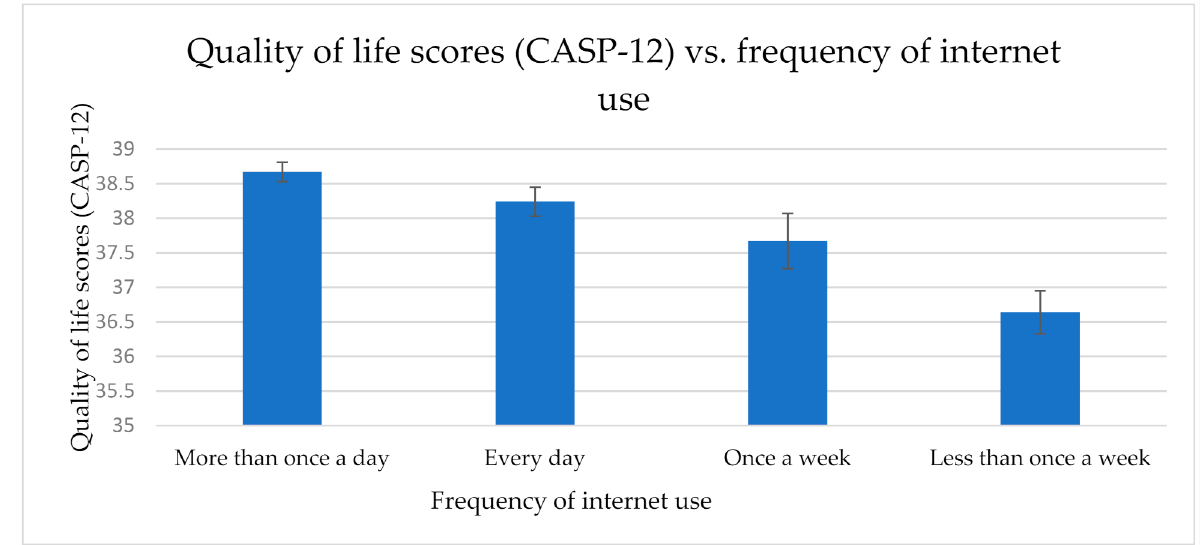
Figure 2. Mean QoL scores (w/standard errors) vs. frequency of internet use. A significant main effect of frequency was observed ( p < 0.001), there was a significant difference between the “less than once a week” group and the “more than once a day” and “every day” groups ( p <